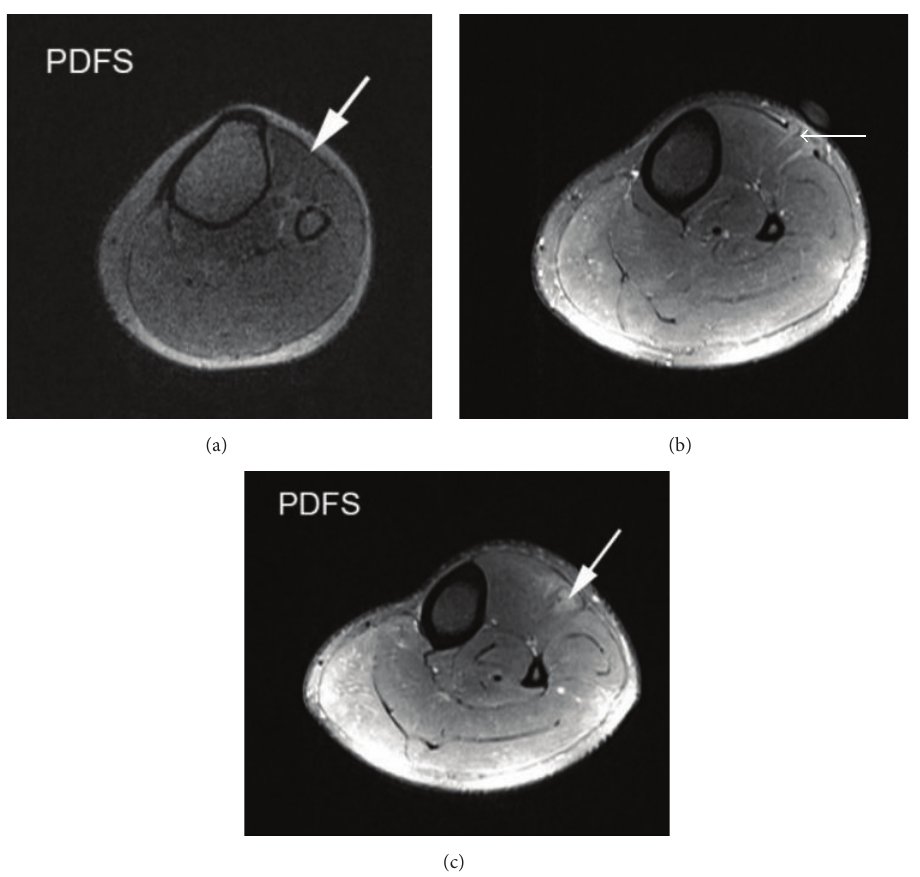
Figure 3: (a) Axial section of left upper leg PDFS sequence showing intact fascia overlying tibialis anterior muscle (marked by arrow). (b) Axial section of left upper leg PDFS sequence showing a defect in the fascia (marked by arrow) overlying tibialis anterior muscle at the level of the marker with resultant herniation of underlying muscle fibers. (c) Axial section of left upper leg PDFS sequence inferior to the level of defect showing intact fascia with a diffuse hyperintense signal in underlying tibialis anterior muscle due to muscle edema (marked by